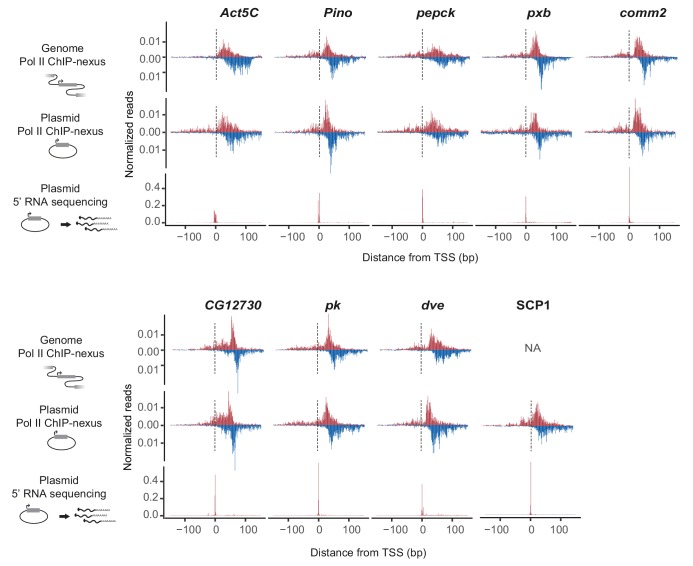
Reporter-ChIP-nexus recapitulates endogenous Pol II pausing.The ChIP-nexus profile of endogenous D. pseudoobscura promoters (first row) strongly resembles the profile detected by reporter-ChIP-nexus after cloning the D. pseudoobscura promoters into the reporter and transfection of the plasmid into Kc167 cells (second row). The artificial super core promoter (SCP) also produces a strong Pol II pausing profile. The transcription start site on the reporter was mapped for each promoter using gene-specific 5’ RNA sequencing (third row) and was found to map to the expected location.